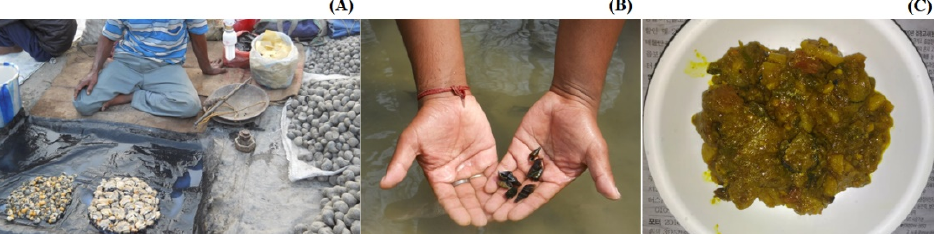
Figure 1. ( A ) Selling of edible snails in the northern part of West Bengal, India (Photo credit: A. Sinha Roy); ( B ) collection of edible snails from a pond in West Bengal, India (Photo credit: A. Sinha Roy); ( C ) cooked Pomacea canaliculata curry in Korea at S.G.’s house.